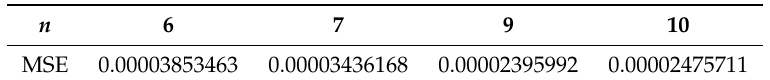
Table 8. n selection for